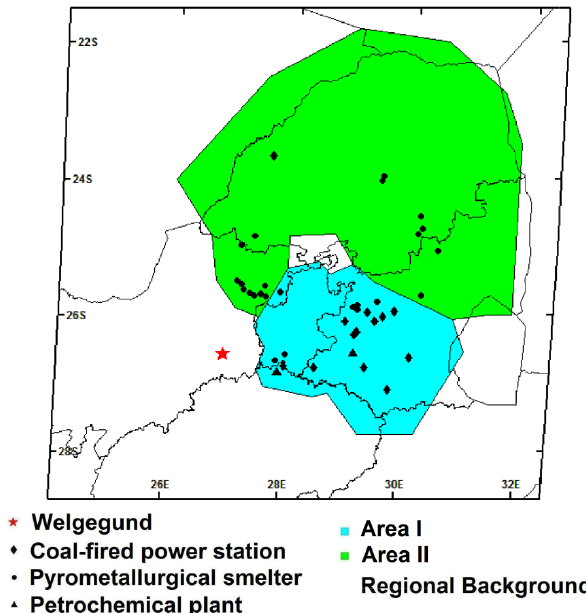
Figure 3. Map of the north-eastern part of South Africa indicat- ing the location of the Welgegund measurement station, large point sources in the industrial hub of South Africa and the source regions defined in this